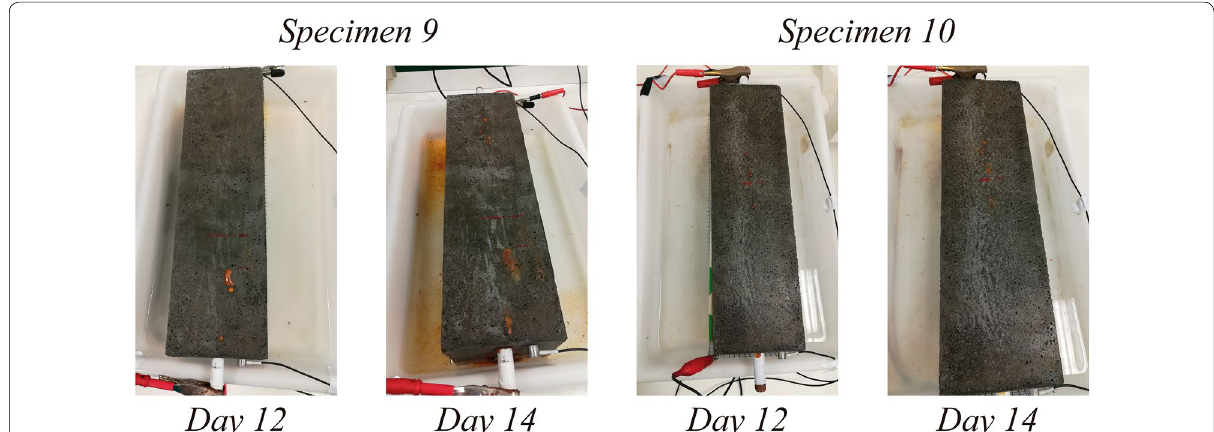
Fig. 9 Photos of specimens number 9 and 10 showing a difference of the intensity of the leaching out of steel corrosion products through the open cracks.